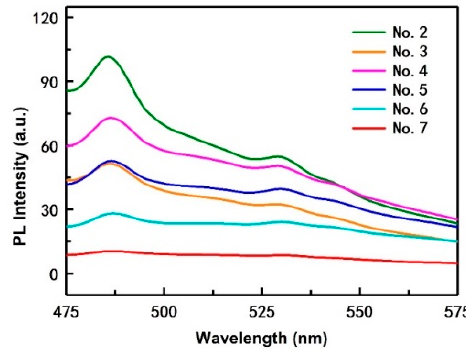
Figure 3. PL spectra of the composite films with different CQDs content at 420 nm excitation wavelengths.